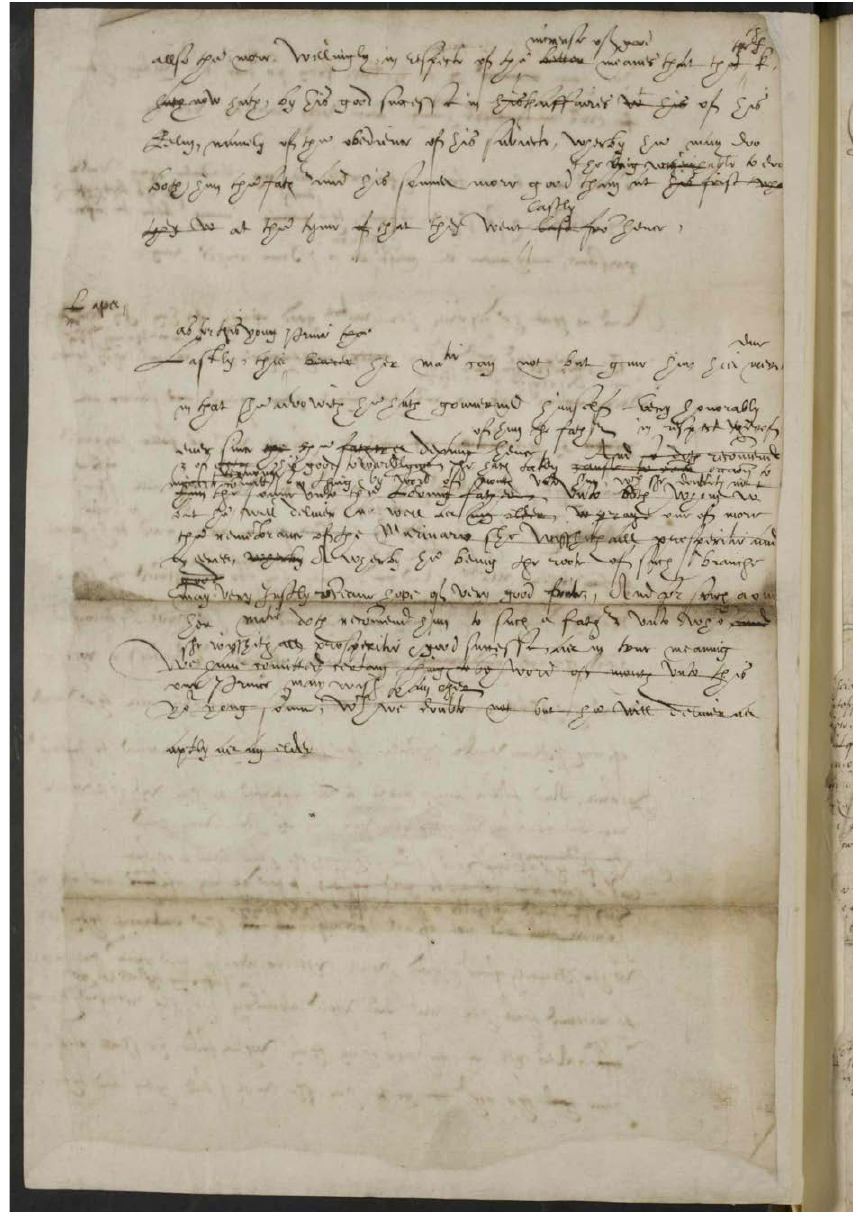
Fig. 5 – Windebanke’s notes for and scribe ‘A’’s version of a letter to Don Antonio of Portugal, 1594 (reproduced by permission of the National Archives,